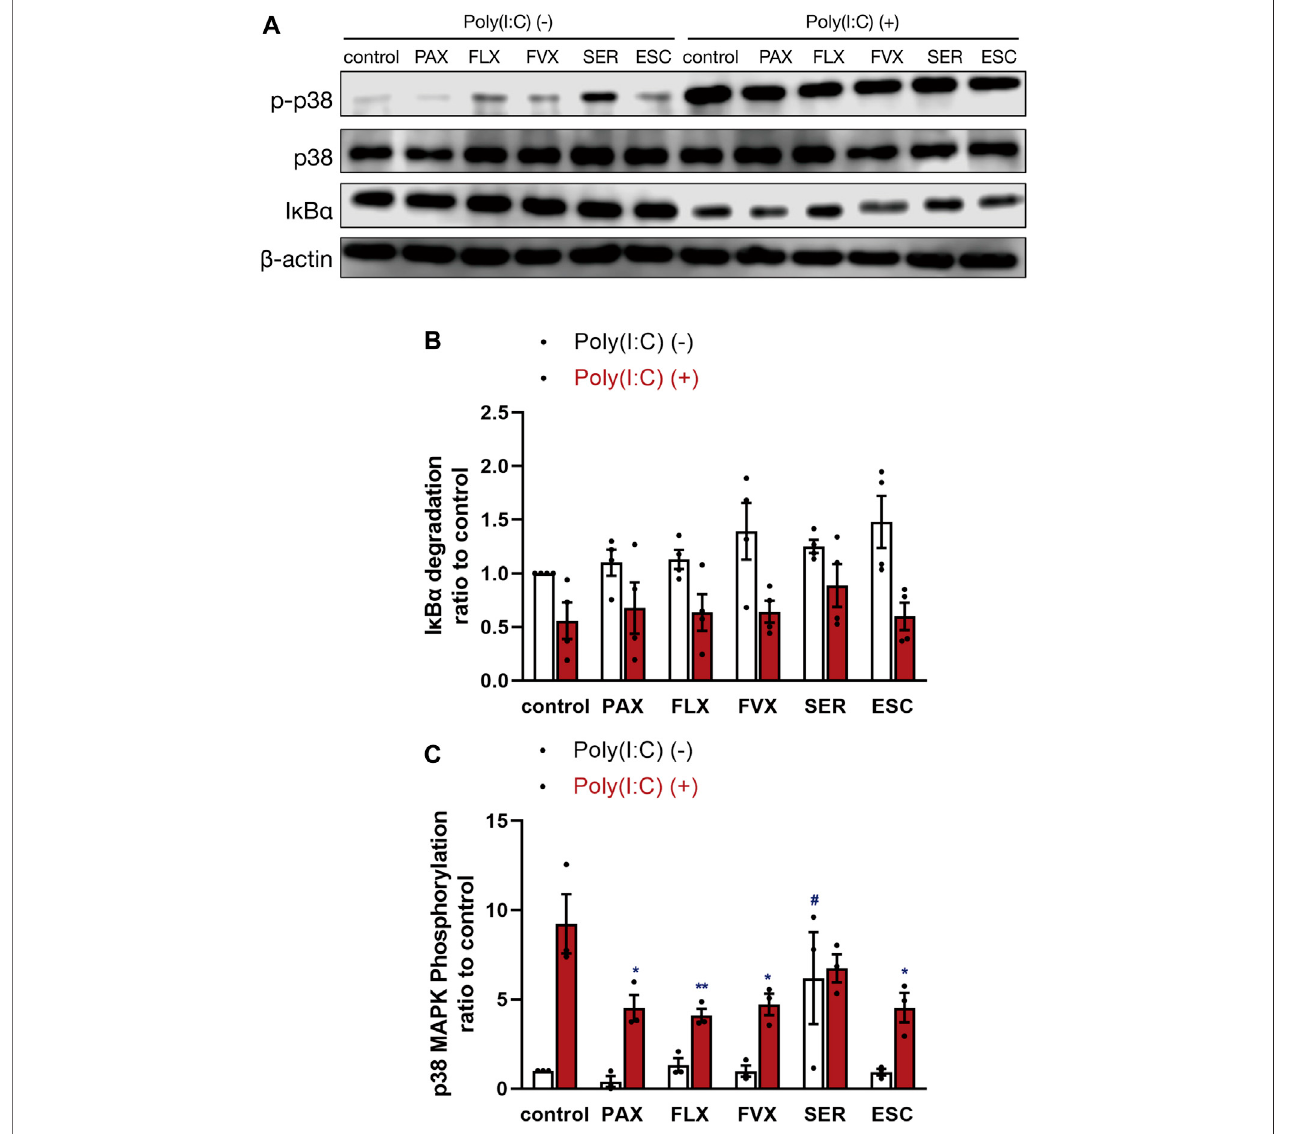
FIGURE 9 | Effects of SSRIs on I κ B α degradation and p38 MAPK phosphorylation induced by a TLR3 agonist in J774.1 murine macrophage cells. J774.1 cells were pre-incubated with each SSRI (10 µM) for 30min, and then incubated with poly(I:C) (5 μ g/ml) for 45 min. The β -actin blot (A,B) or p38 MAPK blot (A,C) is included as a loading control. I κ B α degradation or p38 MAPK phosphorylation was analyzed by Western blotting. Error bars indicate ±SE [ (B) : n = 4, four independent experiments, (C) : n =3, threeindependent experiments). Statistical analysiswasperformed bytwo-way ANOVA followedby Dunnett ’ s test. Signi fi cantdifferences between poly(I:C) ( − ) control and test groups are indicated by # p < 0.01. Signi fi cant differences between poly(I:C) (+) control and test groups are indicated by * p < 0.05, ** p < 0.01. PAX, paroxetine; FLX, fl uoxetine; FVX, fl uvoxamine; SER, sertraline; ESC,